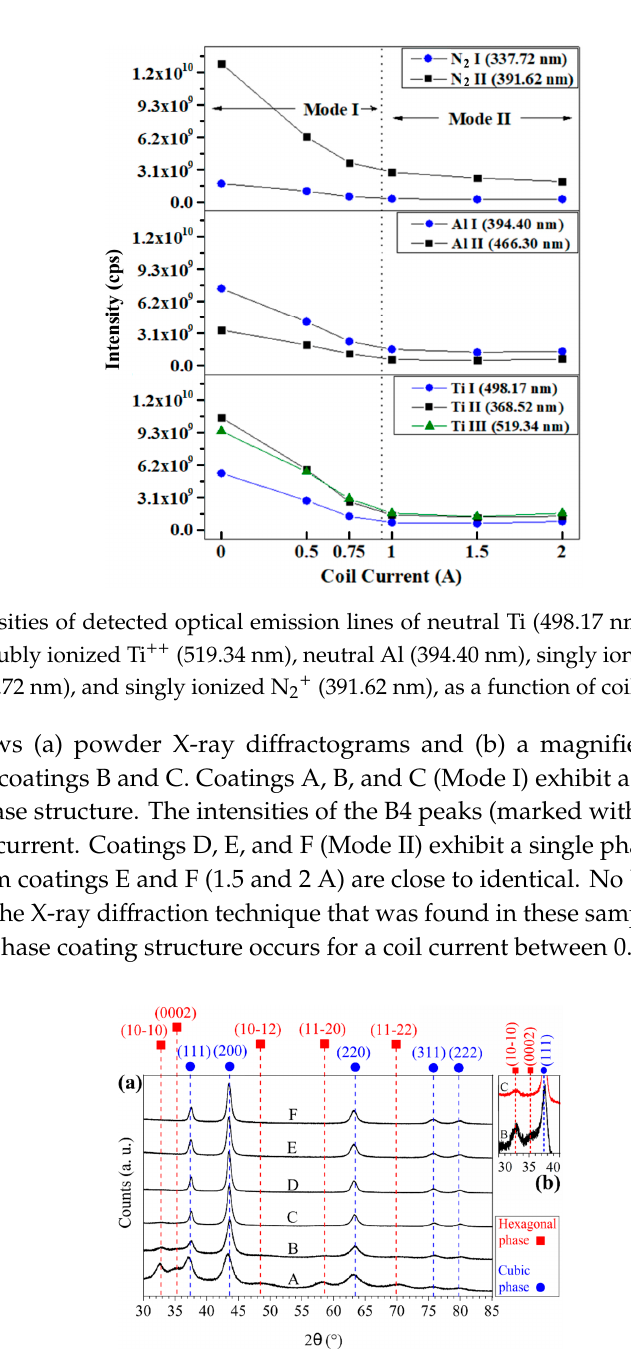
Figure 7. X-ray diffractograms showing ( a ) the phase content as a function coil current. ( b ) The presence of both B1 (cubic) and B4 (wurtzite) phases for coatings B and C.